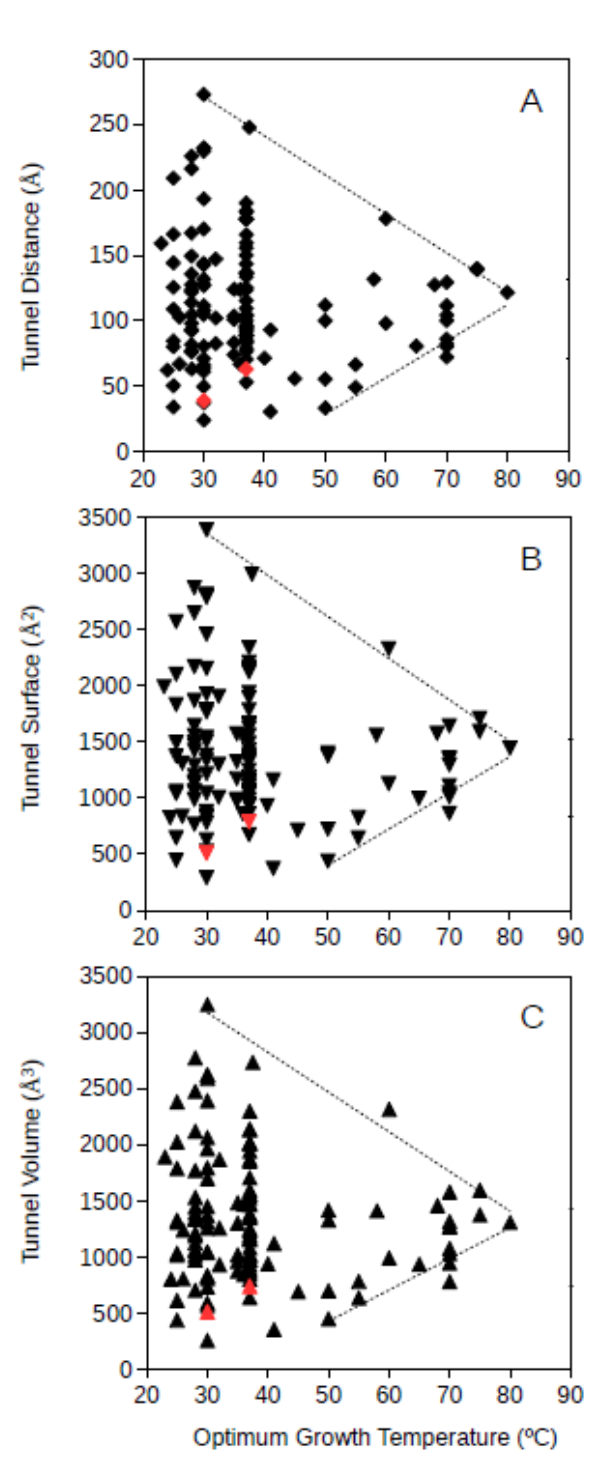
Figure 3. Tunnel distance ( A ), surface ( B ) and volume ( C ) (in Å) dimensions predicted for bacteria GPATs (glutamine phosphoribosylpyrophosphate amidotransferase) ranging in optimum growth temperature from 23 °C to 80 °C. Grey lines represent a visualization of the upper and lower limits for these dimensions at increasing temperatures. Black symbols correspond to predicted protein structures; red symbols correspond to resolved model structures from the Protein Data Bank.